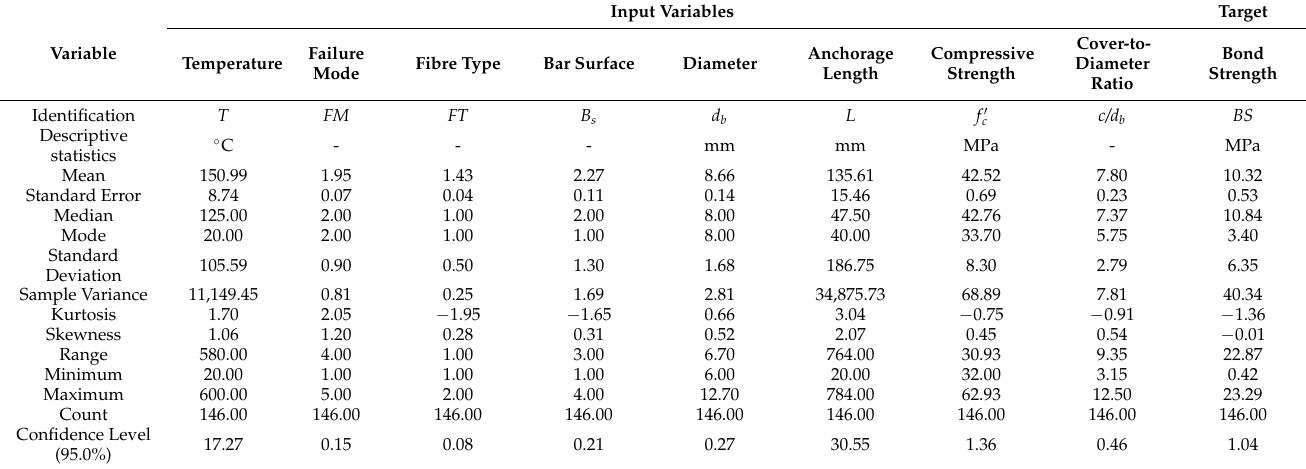
Table 1. Descriptive statistics of input data used in GEP